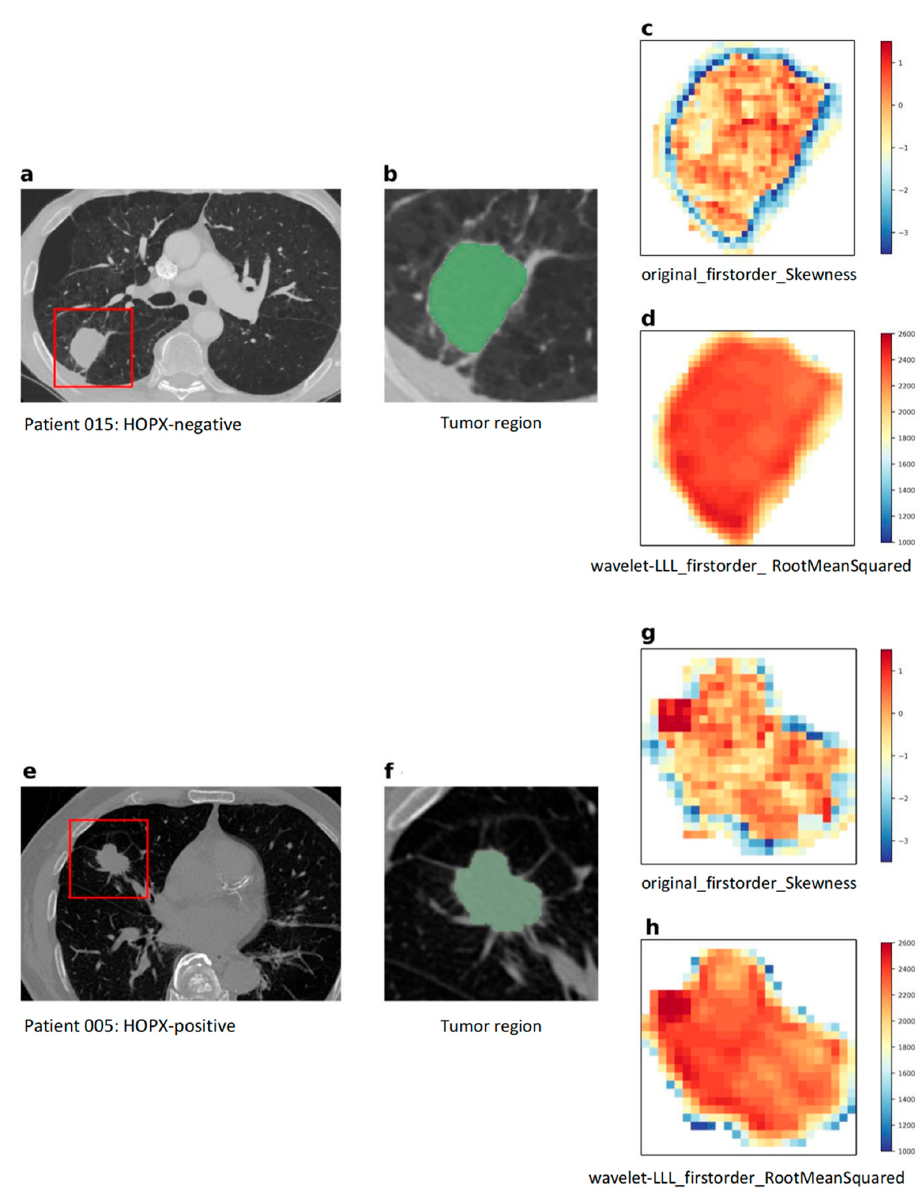
Figure 6. Image feature maps of “original_firstorder_Skewness” and “wavelet-LLL_firstorder_RootMeanSquared,” for two patients with different HOPX expression statuses: ( a ) a CT image from an HOPX-negative patient; ( b ) a tumor region (ROI) for the HOPX-negative patient; ( c , g ) maps of “original_firstorder_Skewness” image feature extracted from ROI; ( d , h ) maps of “wavelet- LLL_RootMeanSquared” image feature extracted from ROI; ( e ) a CT image from an HOPX-positive patient; ( f ) a tumor region (ROI) for the HOPX-positive